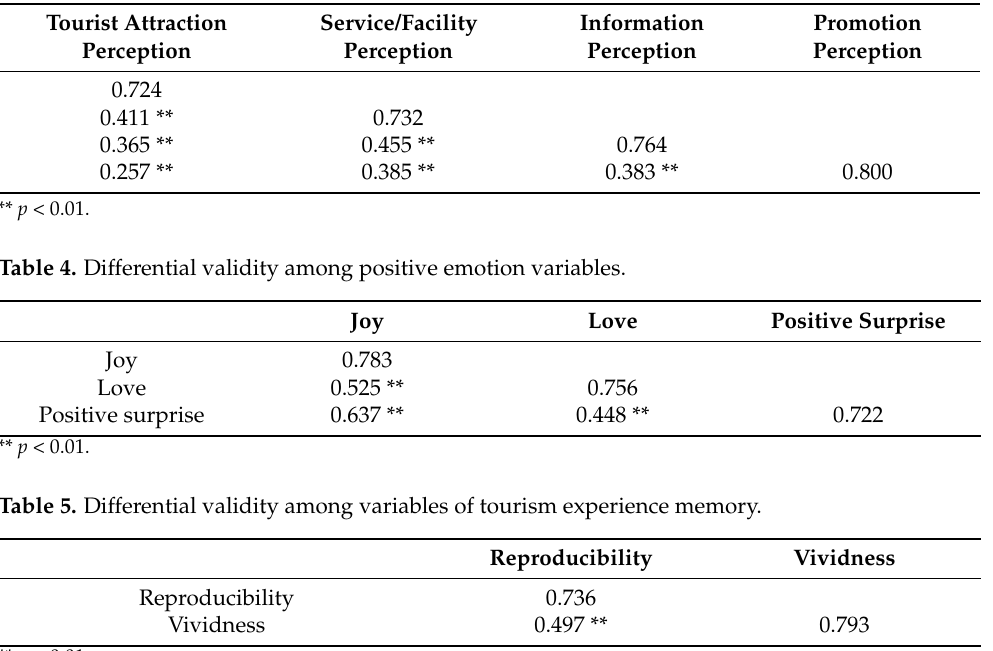
Table 3. Differential validity among perceived variables of rural tourism destination supply.